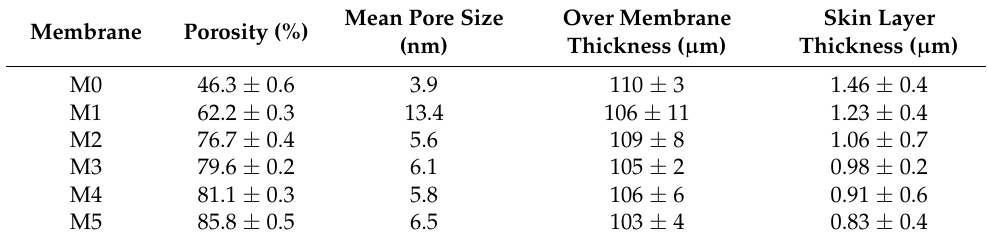
Table 2. Physical properties of resultant membranes.